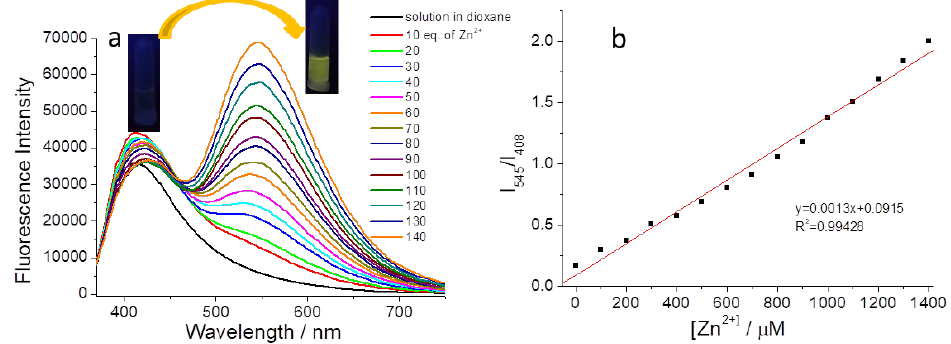
Figure 10. ( a ) The fluorescence titration of solution 1 by Zn 2+ . ( b ) The curves of the fluorescence emission intensity ratio of I 545 /I 408 of solution 1 versus the concentration of Zn 2+ . The inset figures were images of solution 1 before and after adding Zn 2+ under 365 nm light lamp.